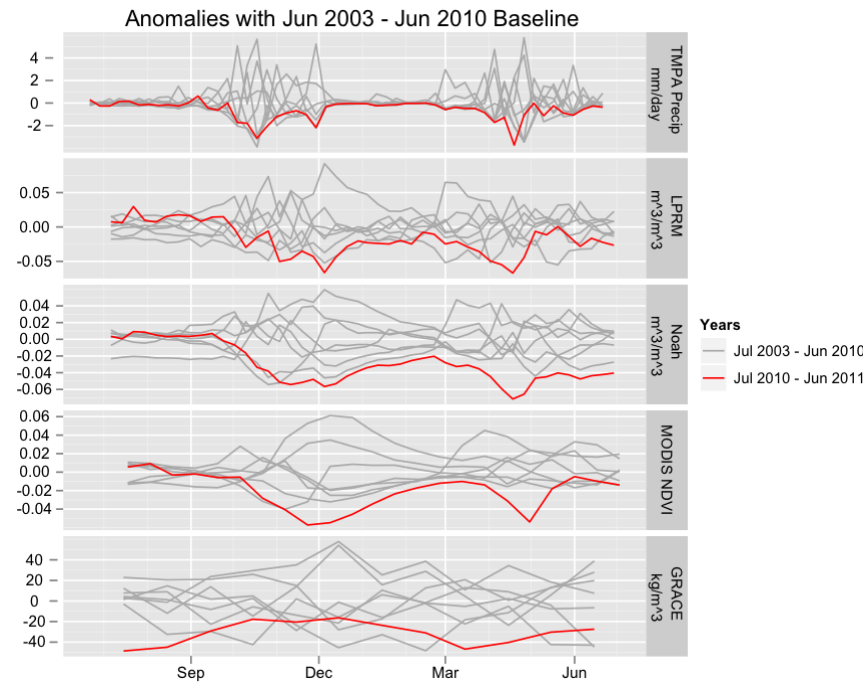
Fig. 3. Anomaly analysis of TMPA precipitation, LPRM and Noah soil moisture estimates, MODIS NDVI and GRACE terrestrial water storage using a January 2003 to June 2010